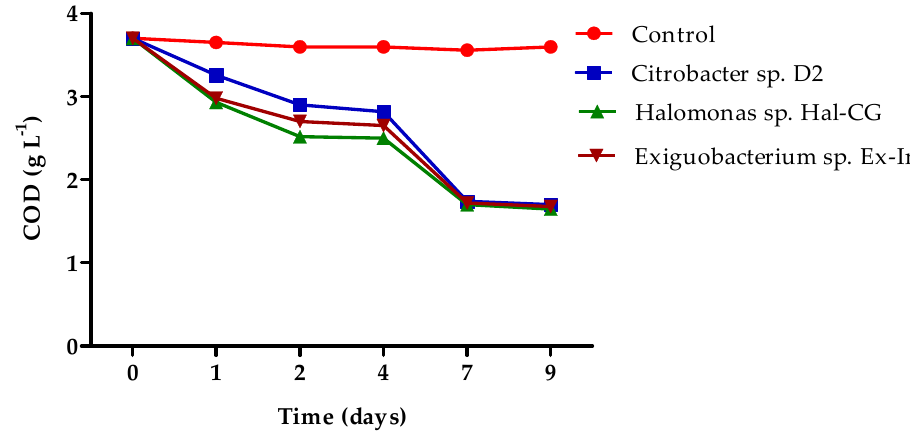
Figure 4. Decrease of COD concentration (g L − 1 ) over time in bilge water (low range) after cultivation with isolated bacterial strains.